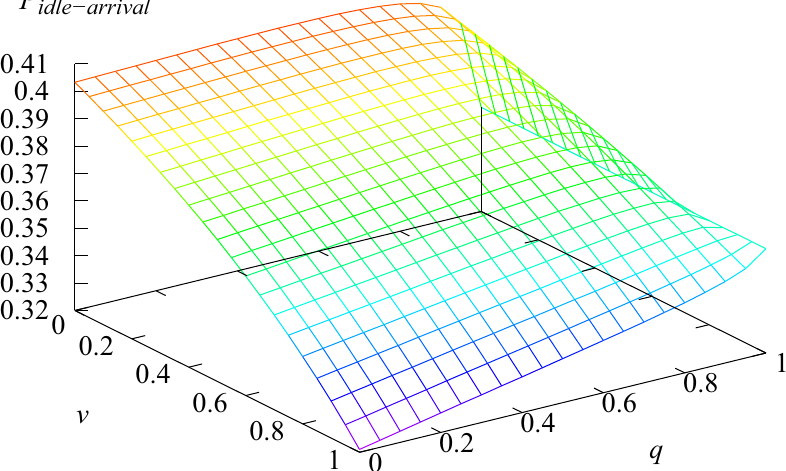
Figure 10. Dependence of the probability P idle − arrival that the system is idle at an arbitrary arrival moment on the parameters q and ν